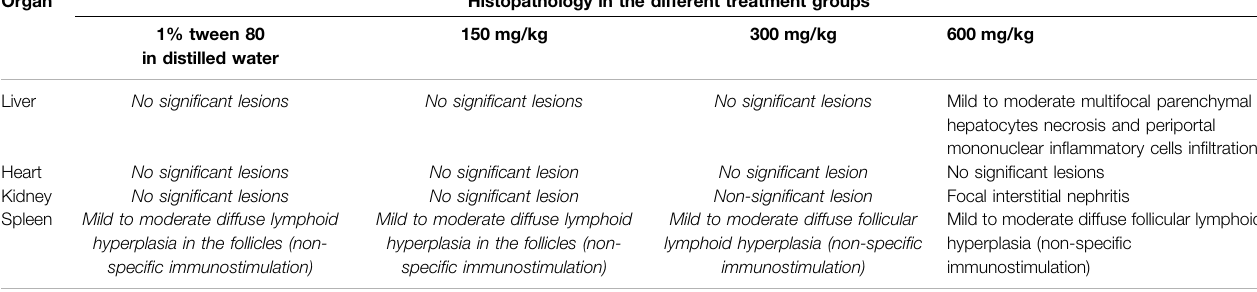
TABLE 6 | Summary of organ speci fi c histopathology. Organ Histopathology in the different treatment